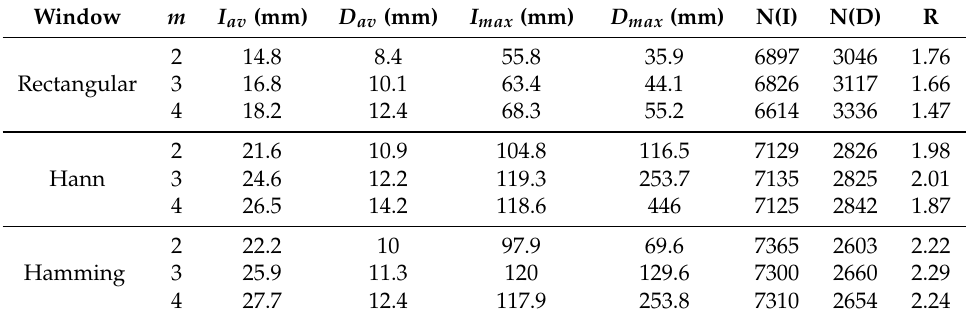
Table 1. Comparison of improvement and degradation of tracking performance of the system with earliest 1/ m peak